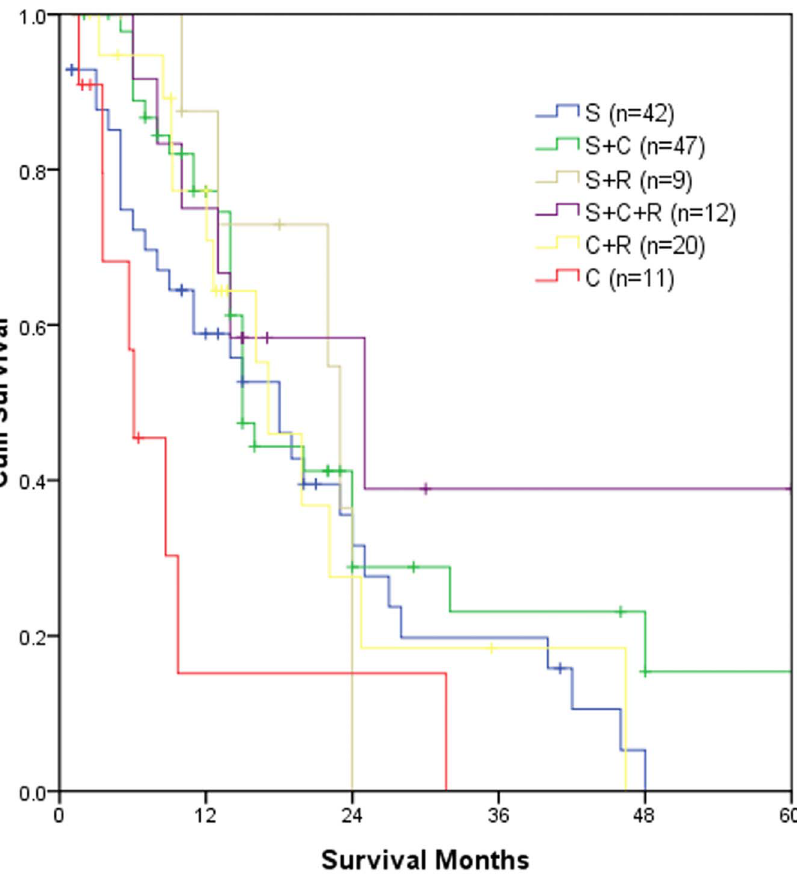
Figure 1. Survival curves for different treatment groups (n=141). S, surgery; C, chemotherapy; R, radiotherapy. Among the six groups, p =0.018; S vs. S + C, p =0.155; S vs. S + R, p =0.842; S vs. S + C + R, p =0.155; S vs. C + R, p =0.695; S vs. C, p =0.064; S + C vs. S + R, p =0.828; S + C vs. S + C + R, p =0.483; S + C vs. C + R, p =0.530; S + C vs. C, p , 0.001; S + R vs. S + C + R, p =0.434; S + R vs. C + R, p =0.849; S + R vs. C, p =0.061; S + C + R vs. C + R, p =0.380; S + C + R vs. C, p =0.010; C + R vs. CR, p =0.013.